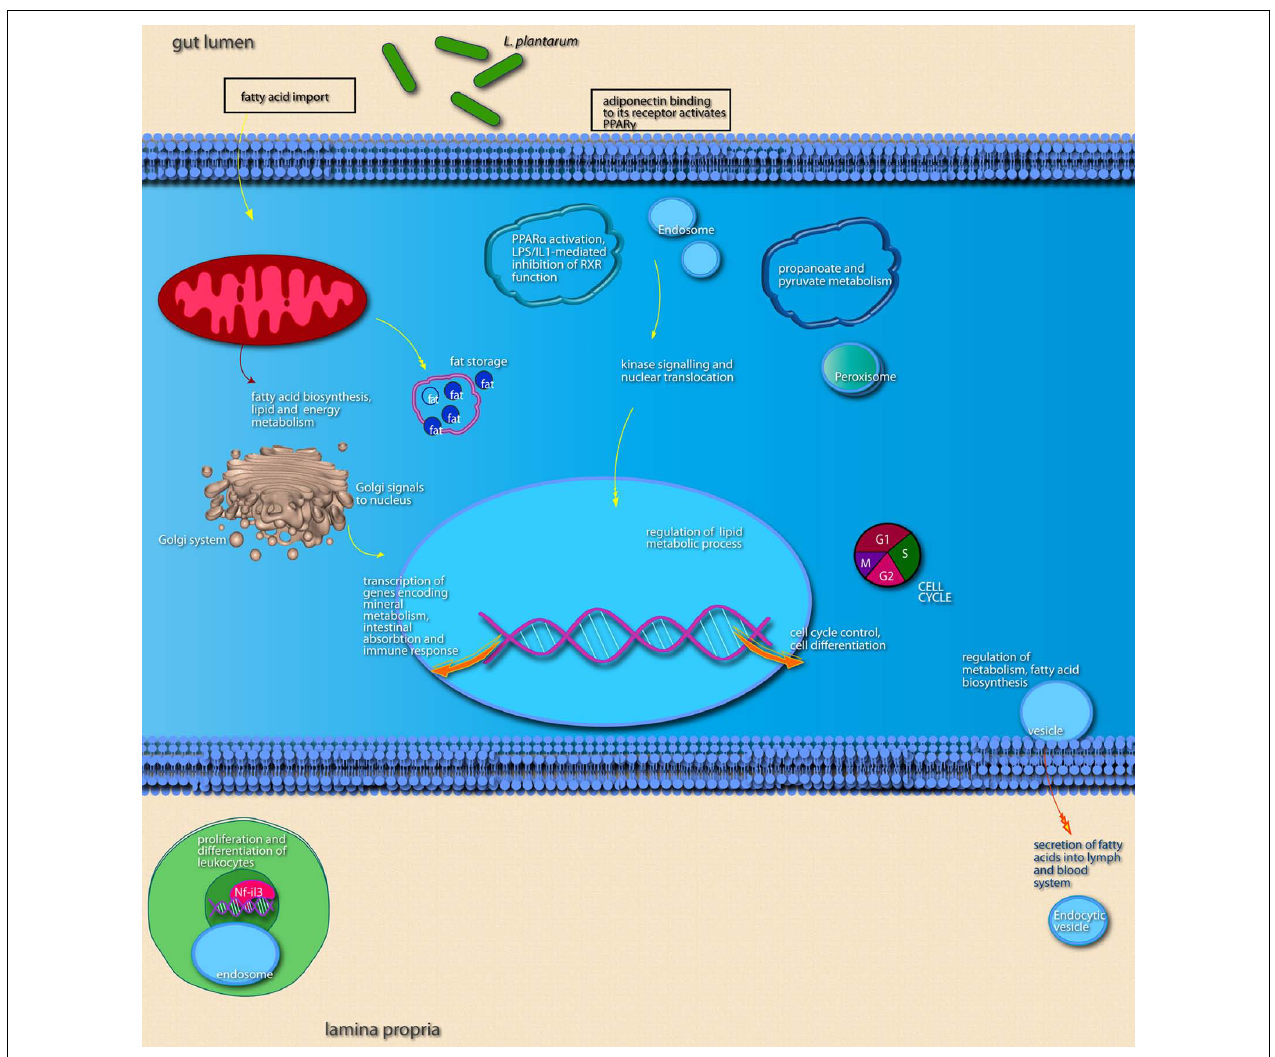
numbers of genes encoding factors involved in lipid metabolism and of genes encoding transcription factors that regulate intestinal absorptive functions and the immune